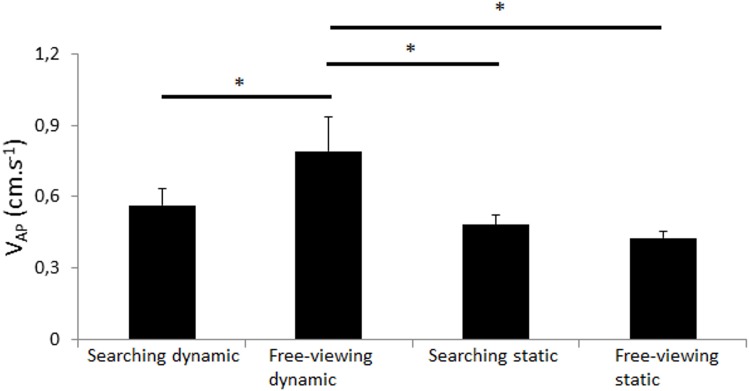
Mean velocity in antero-posterior.Mean velocity in antero-posterior (in cm.s-1) in both searching task (static and dynamic) and in both free-viewing task (static and dynamic). Vertical bars indicate the standard error. Horizontal bars indicate significant interactions.